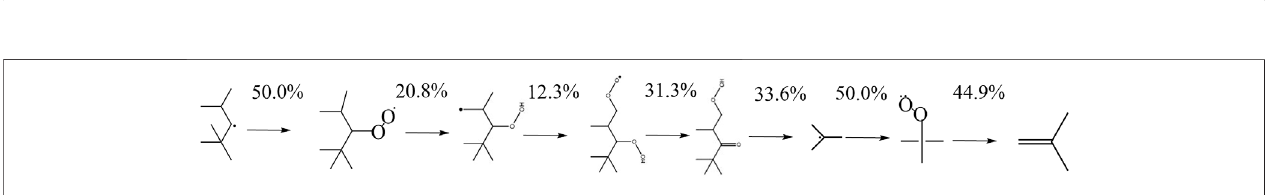
Frontiers in Energy Research |